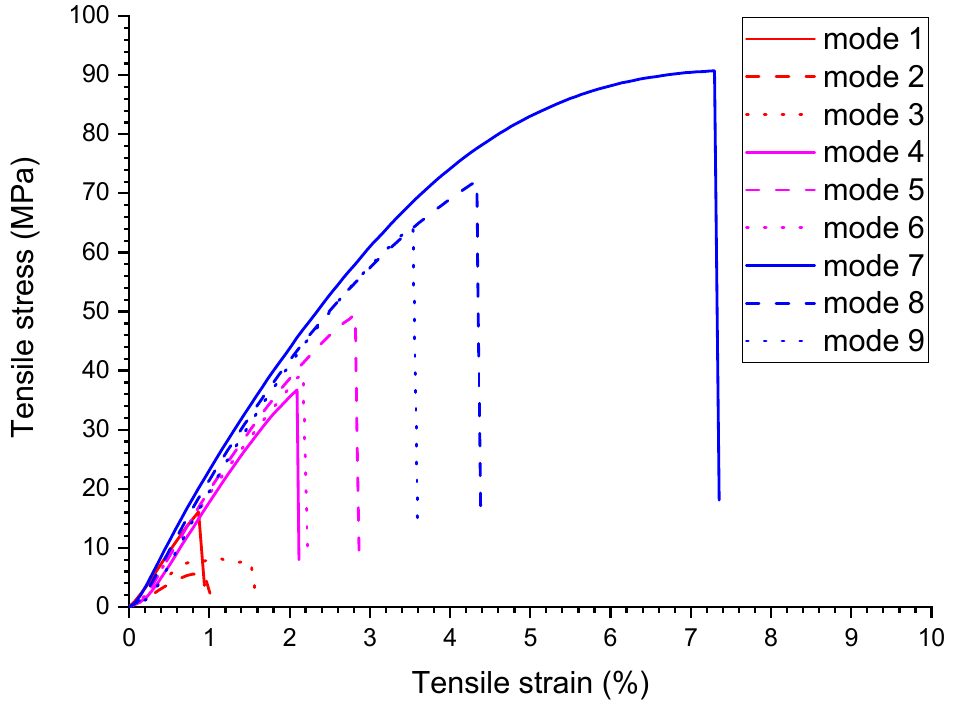
Figure 4. The strain–stress diagrams for the USW lap joints obtained using modes 1–9. Table 3. The mechanical and dimensional characteristics of the USW lap joints for various USW parameters.